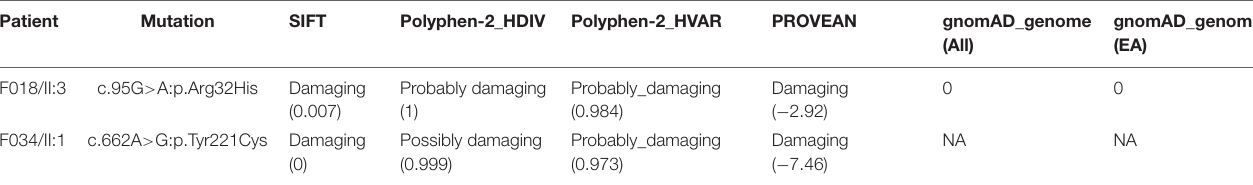
TABLE 2 | In silico analysis of the pathogenic variants in ACTRT1